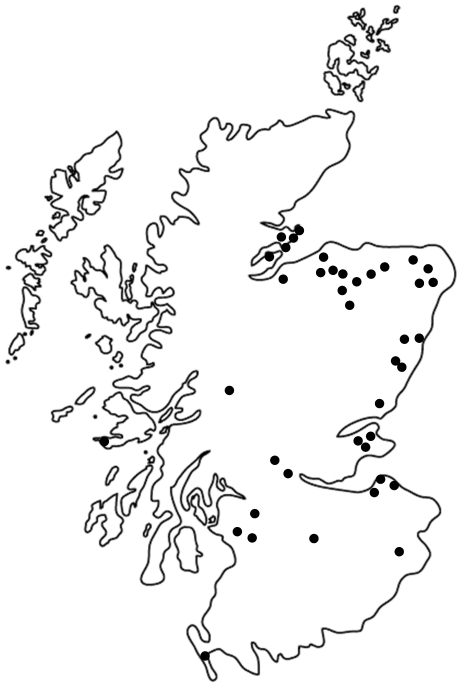
Distribution of sample locations in Scotland (n = 46).